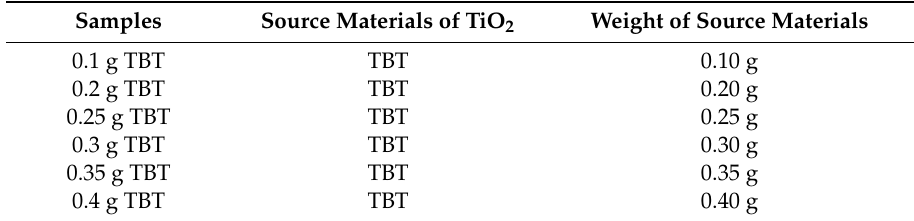
Table 1. The prepared samples of the tetrabutyl titanate (TBT) series.